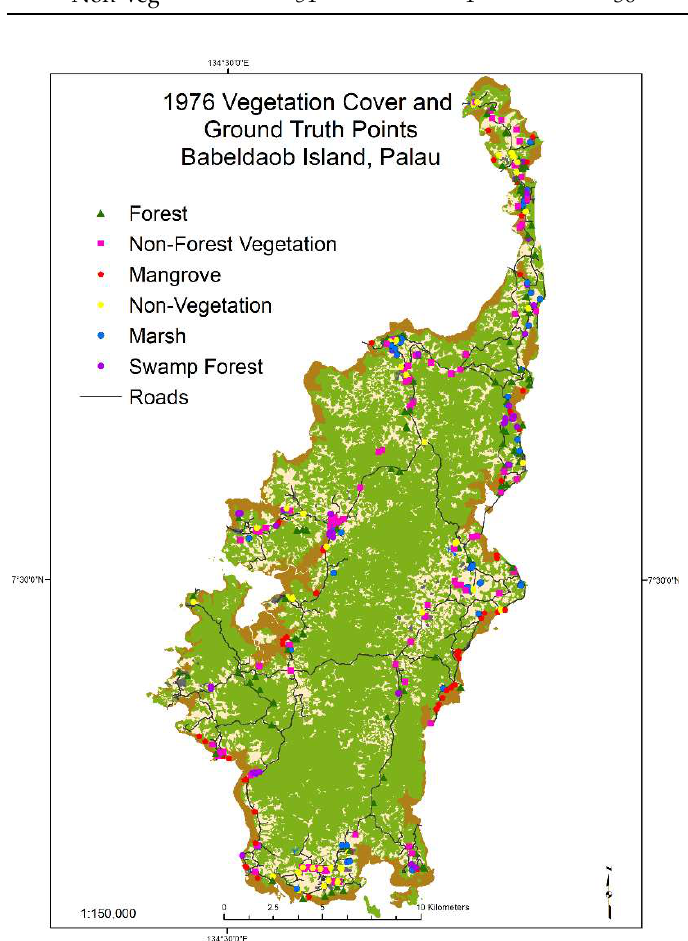
Figure 2. Babeldaob Island showing 1976 cover of four main vegetation types and vegetation ground-truth points visited in 2012.